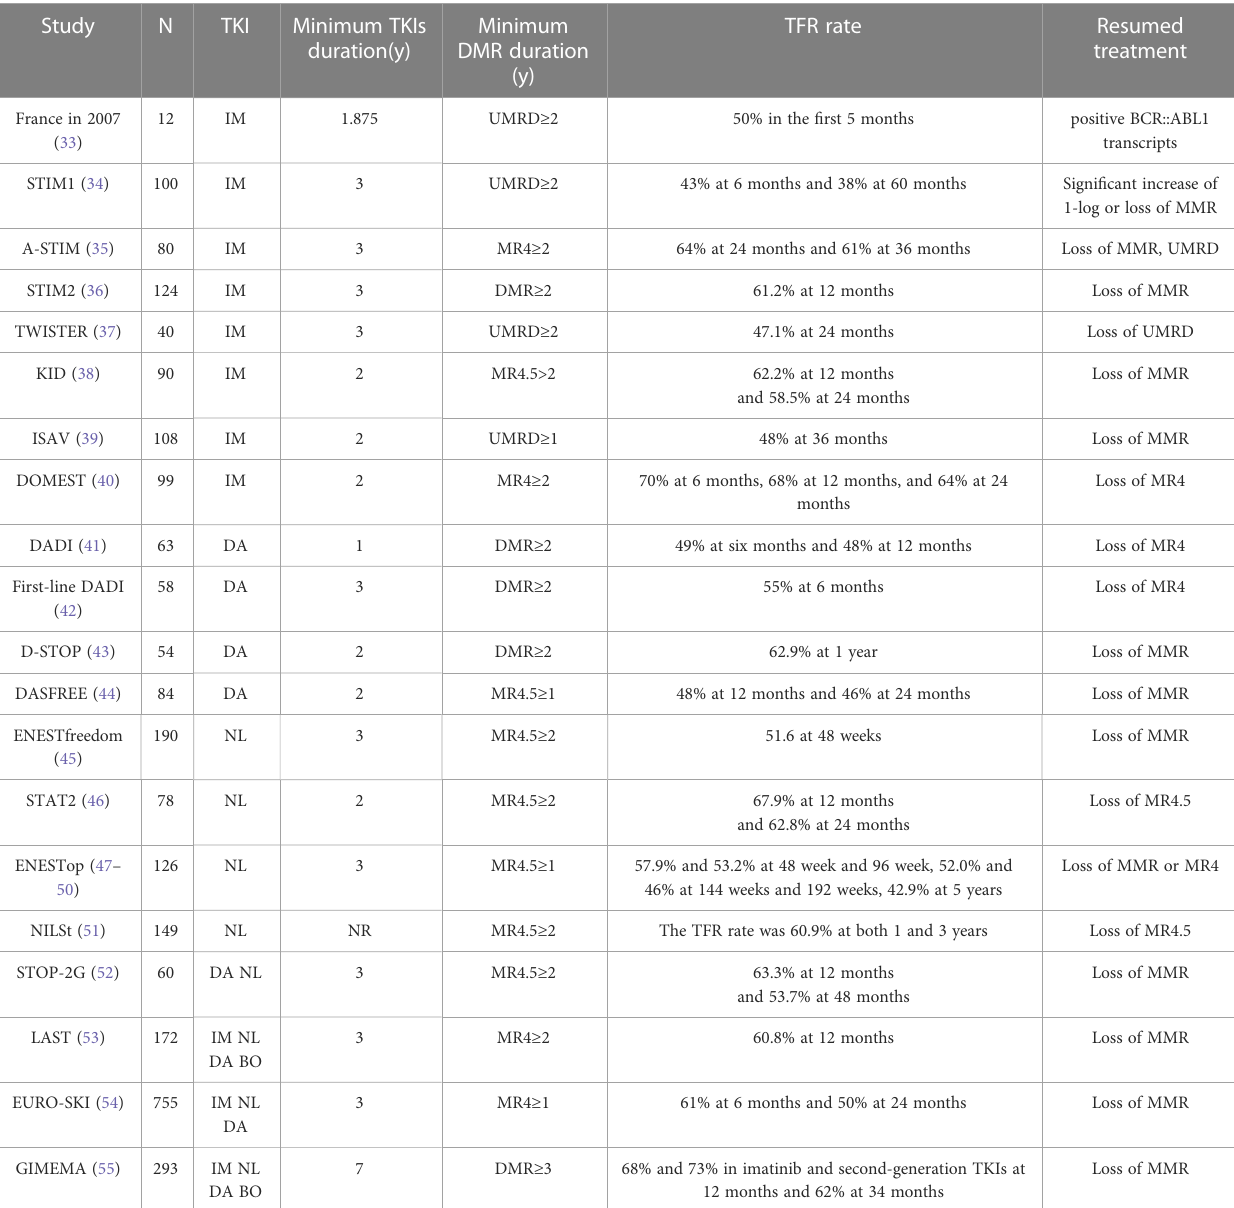
TABLE 2 Characteristics of TKIs discontinuation